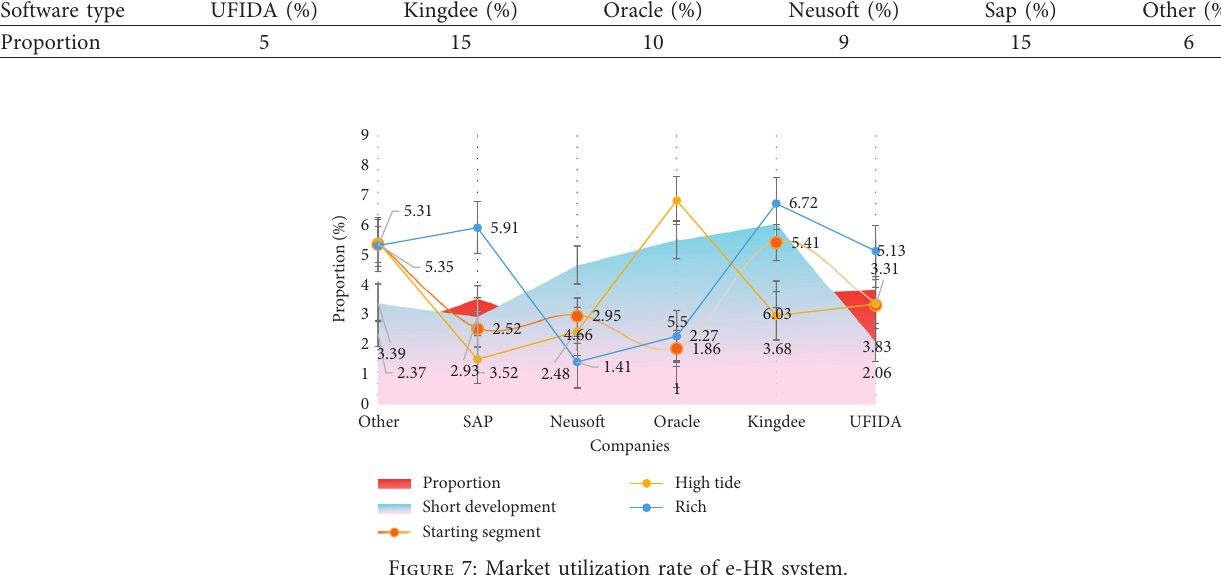
Table 8: Market utilization rate of e-HR system.